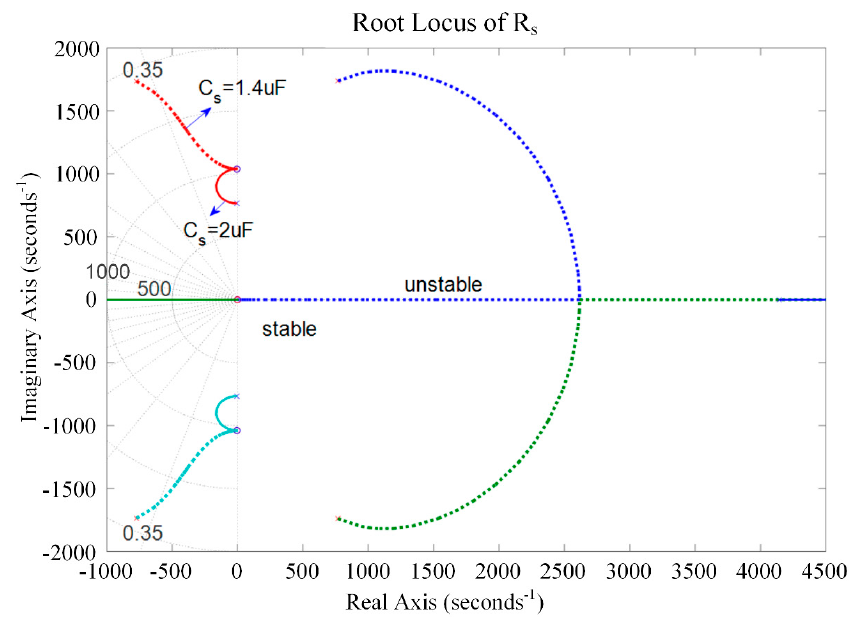
Figure 14. Root locus of the piezoelectric stack transducer with respect to R s for the negative inductance / negative resistance in series with R s .